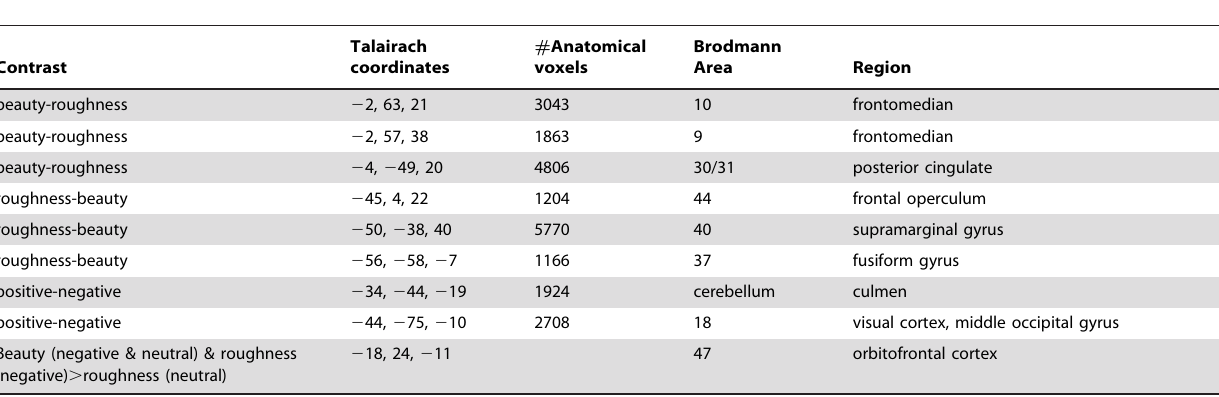
Table 1. Activation clusters in the contrasts between the judgments and the different beauty levels of the stimuli, and their